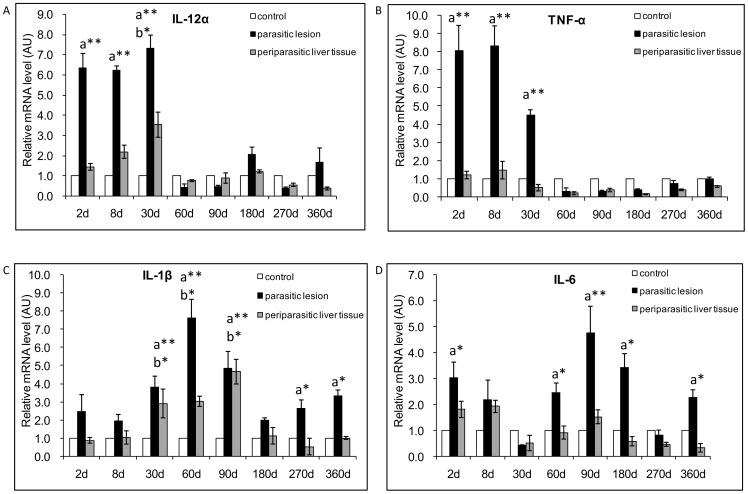
Course of IL-12α and pro-inflammatory cytokine gene expression in the liver of mice during E. multilocularis infection (measured by qRT-PCR).(A) IL12α, (B) TNF-α, (C) IL-1B, (D) IL-6. a: ‘Parasitic lesion’ versus ‘Control’; b: ‘Periparasitic liver tissue’ versus ‘Control’. *P<0.05; **P<0.01. ‘Control’, non-infected mice; ‘Parasitic lesion’: E. multilocularis metacestode and surrounding immune infiltrate; ‘Periparasitic liver tissue: liver parenchyma close to the E. multilocularis lesion, but excluding macroscopically visible liver tissue alterations. AU: arbitrary units.